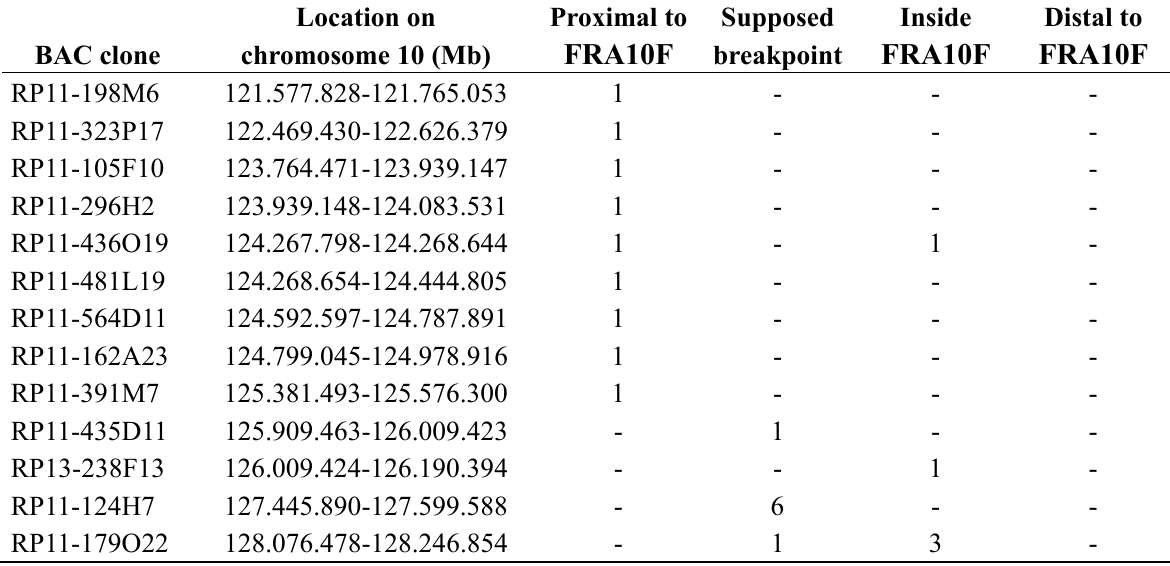
Table 2. List of 13 BAC clones used for mapping of the proximal boarder of FRA10F. Location on BAC clone chromosome 10